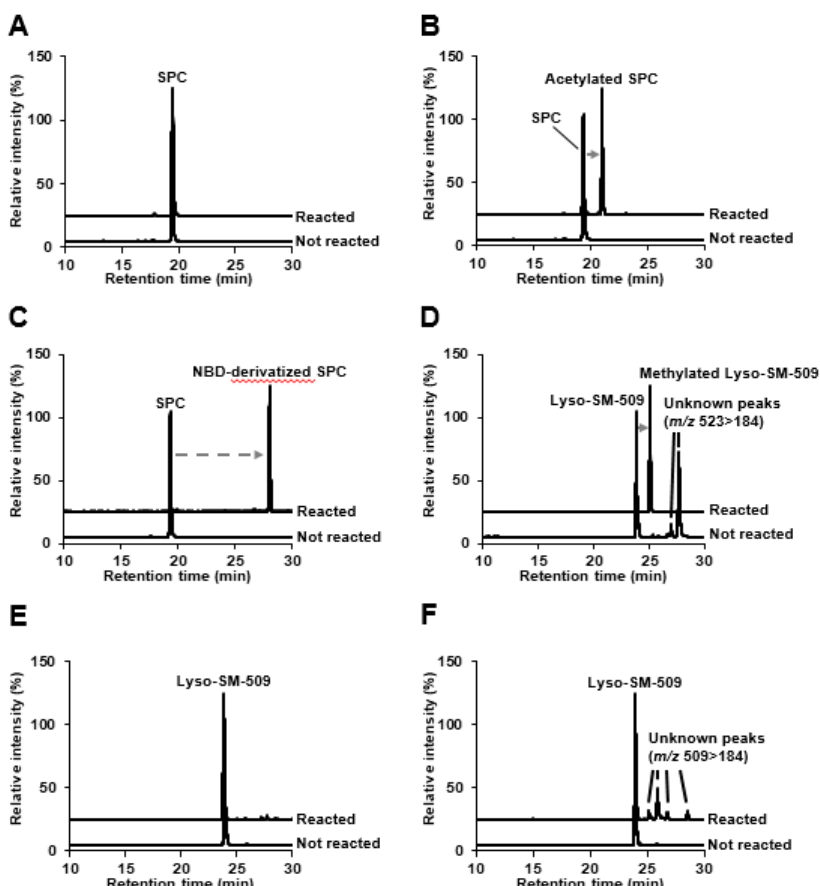
Figure 3. Derivatization for SPC and Lyso-SM-509. ( A ) Selected reaction monitoring (SRM) analysis of methyl esterified SPC. Upper, reacted SPC; lower, SPC. ( B ) SRM analysis of acetylated SPC. Upper, reacted SPC; lower, SPC. ( C ) SRM analysis of NBD-derivatized SPC. Upper, reacted SPC; lower, SPC. ( D ) Estimation of the carboxy group on Lyso-SM-509 by methyl esterification. ( E ) Estimation of the hydroxy group on Lyso-SM-509 by acetylation. ( F ) Estimation of the amine group on Lyso-SM-509 by NBD-derivatization. NBD, 7-nitro-2,1,3-benzoxadiazole; SRM, selected reaction monitoring.